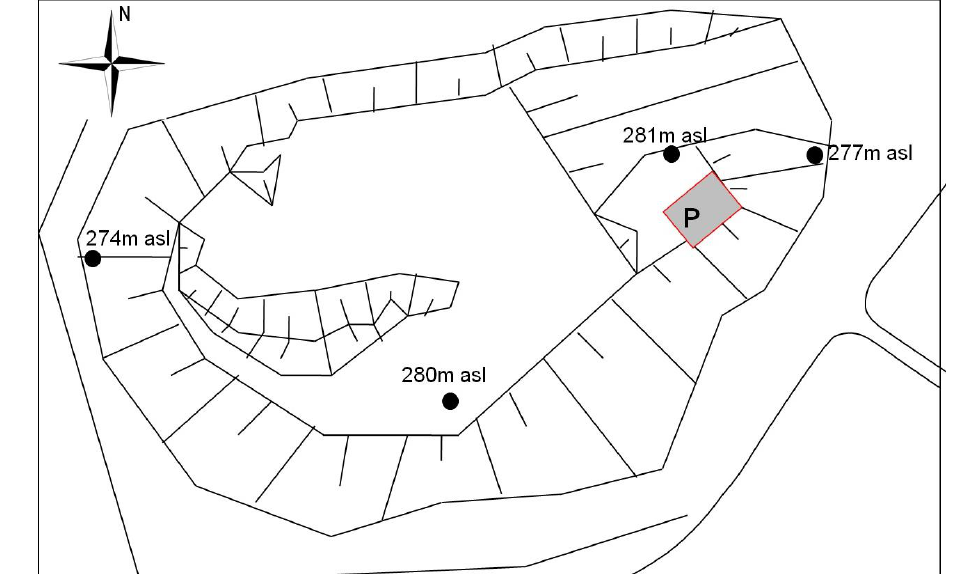
Fig. 4. Scheme of the research layout – "Dołki" washery spoil heap ZGH "Orzeł Biały" in Piekary Śląskie. The symbol P indicates the location of the